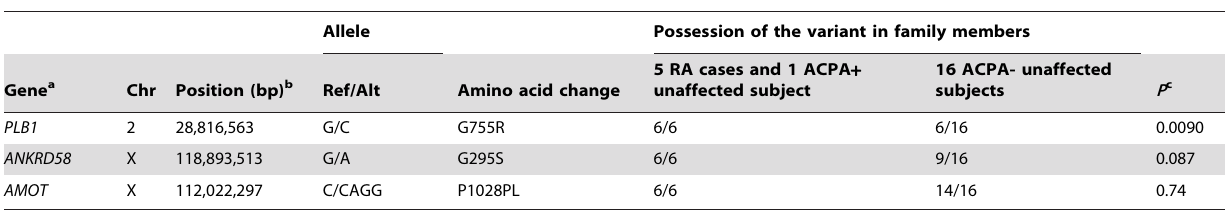
Table 1. Results of the validation assay for candidate variants derived from exome